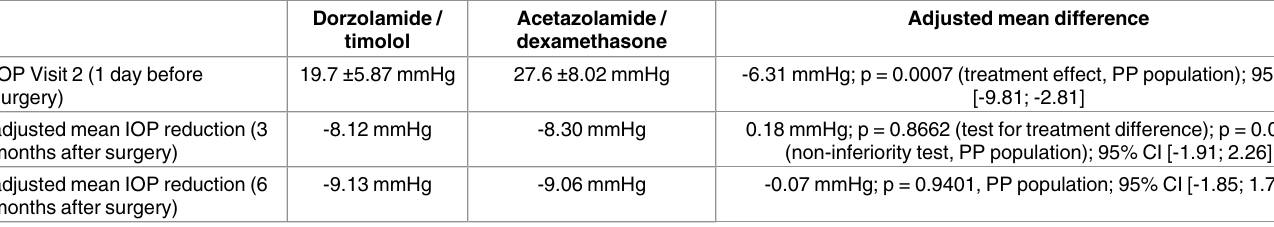
Table 4. Differencesin IOP increaseand decreasebetween the treatment groups.